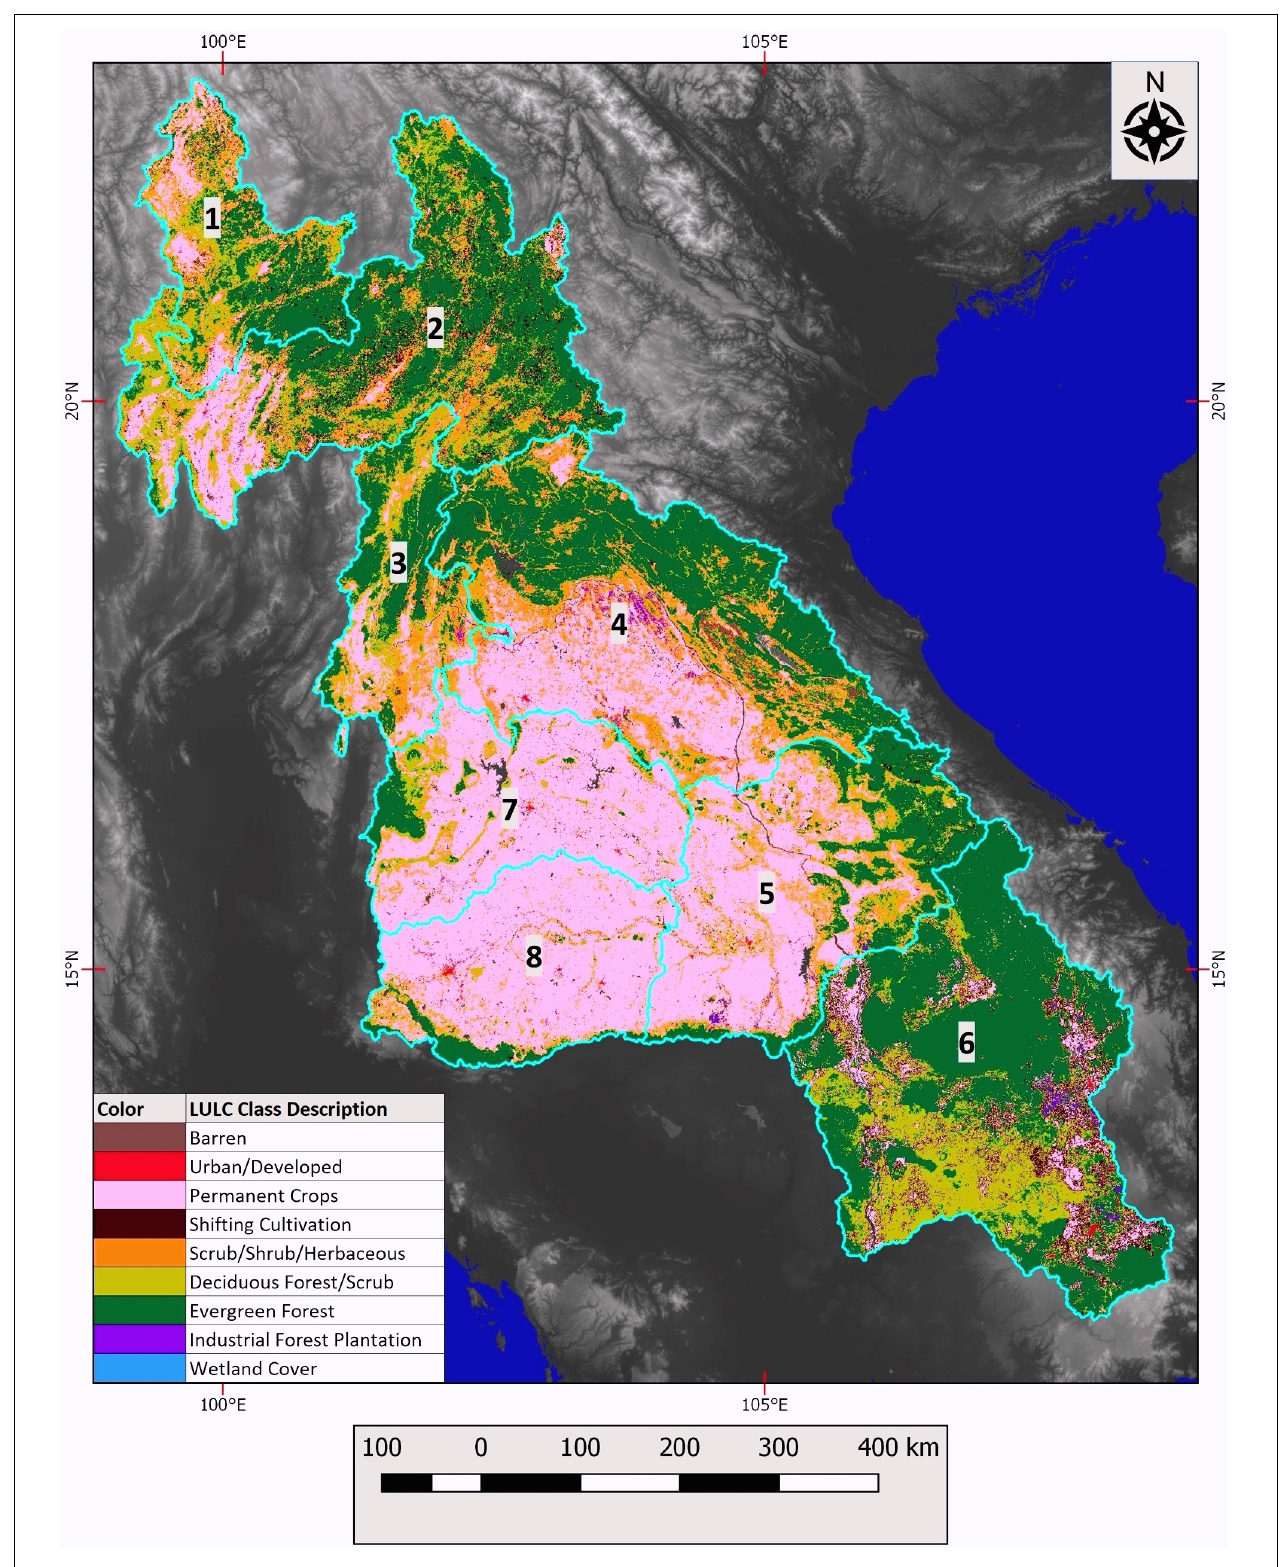
FIGURE 3 | Study area 2010 LULC map with SB boundaries overlain in cyan for SBs 1–8. The SB #s are included as black text. The backdrop image adjacent to the LULC map is a 90 m DEM from SRTM data.